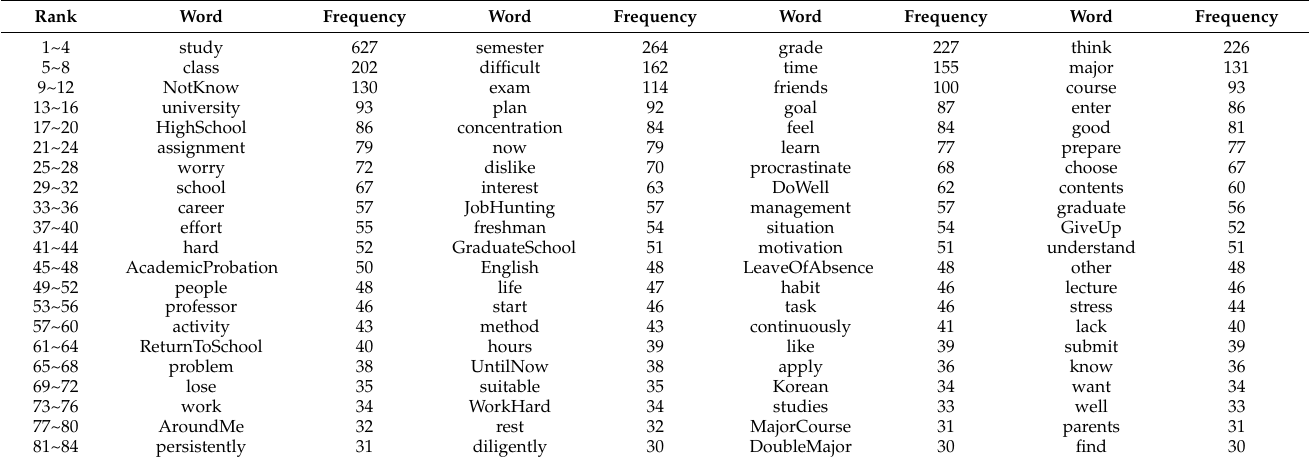
Table A4. Keywords after COVID-19 (2020–2021) with frequency of 30 or